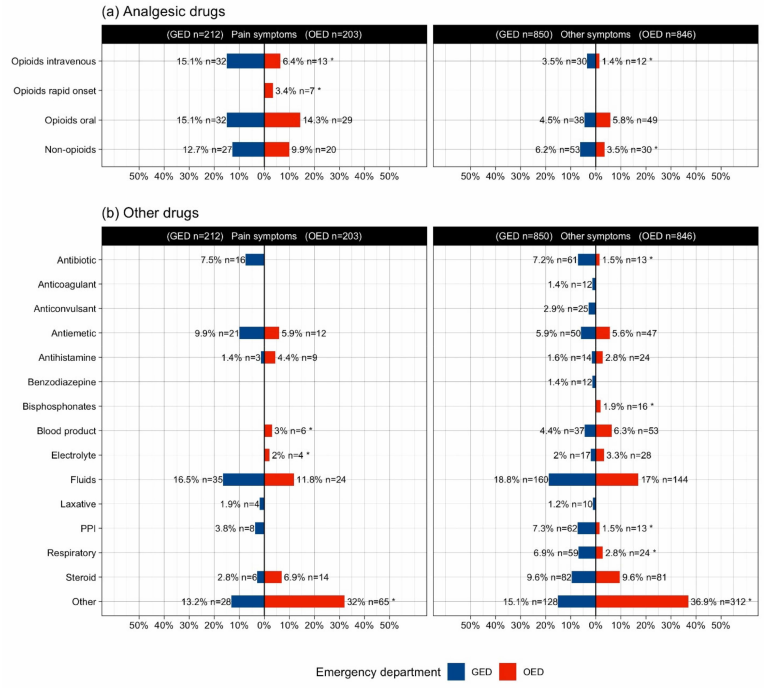
Figure 1. Title: Drug administration for pain and other symptoms according to emergency set- ting. Legend: Practices of drug administration significantly differed by emergency setting, both for pain and other symptoms. Section ( a ) refers to direct pain drugs, while ( b ) to non-pain medica- tions. GED—General emergency department; OED—Oncology emergency department. * denotes statistical